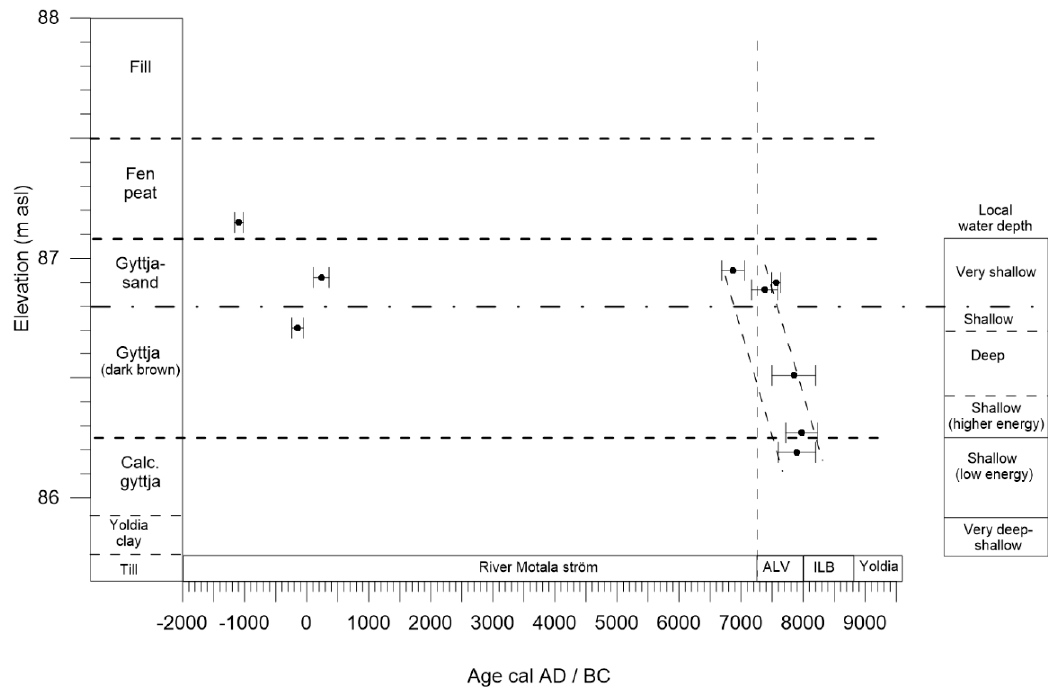
Figure 7. Stratigraphy and 14 C-dates (2 σ error) of section C 13059. The section contains sediment from the deepest part of the investigated basins in Motala. ALV = Ancient Lake Vättern transgression. ILB = Isolated Lake Basin (Lake Strandvägen). Diagonal dashed lines are suggested age-depth interval for the uppermost calcareous gyttja (ILB gyttja), dark brown gyttja (ALV gyttja) and lowermost gyttja-sand (River sediment). The boundary between the dark brown gyttja and the gyttja-sand is gradual and mainly based on sampling levels of macrofossils. The local water depth reconstruction is based on macrofossils and sediment properties, such as sand and silt/clay content.